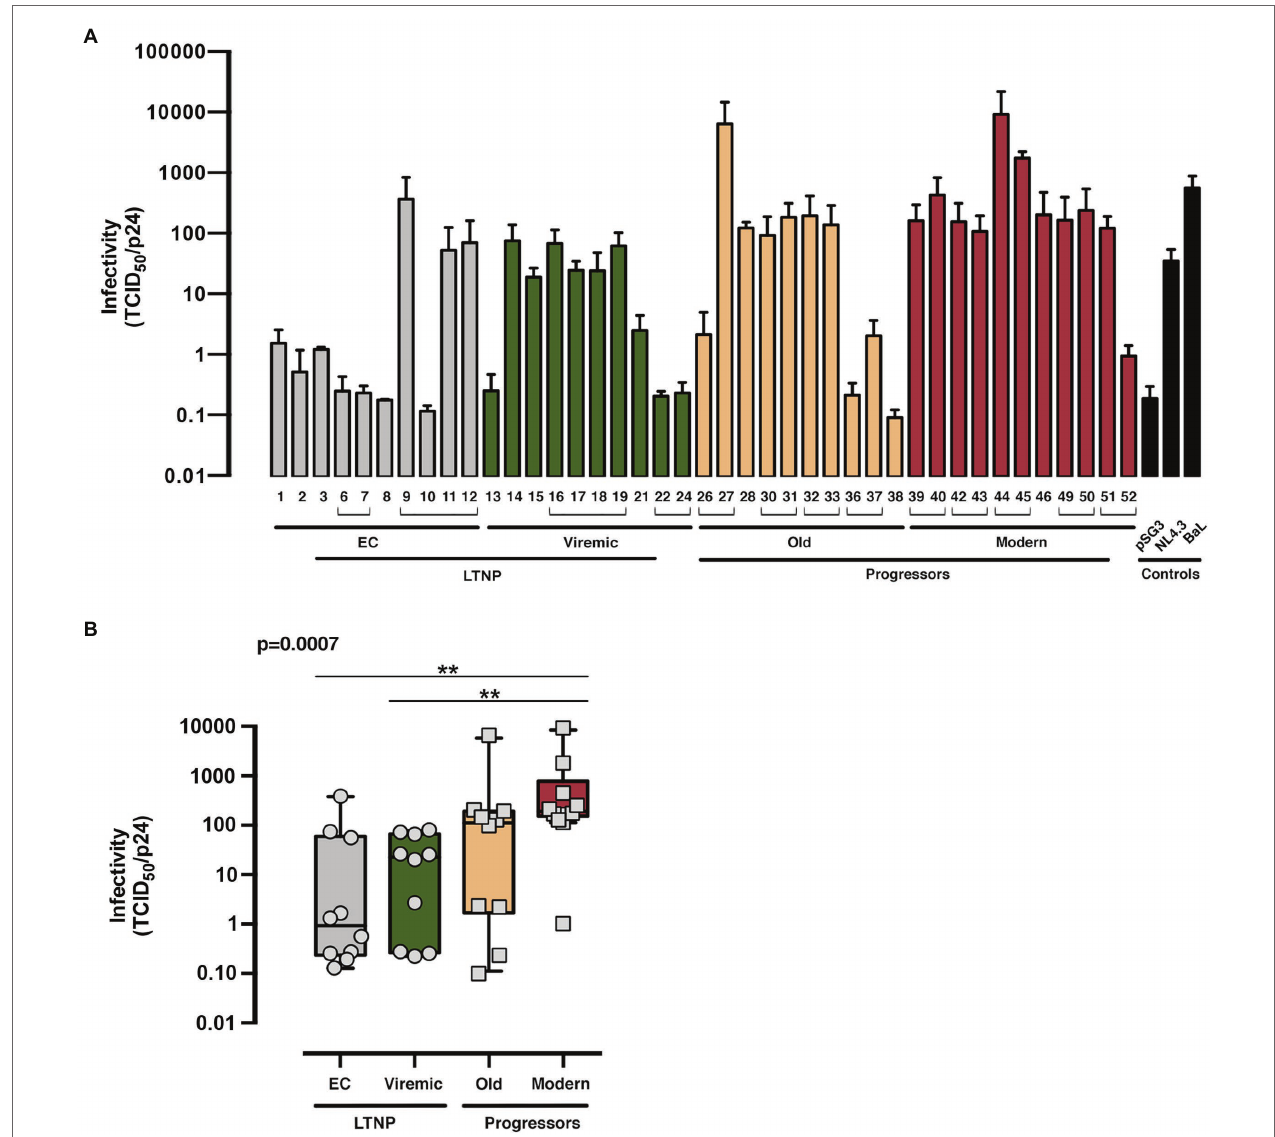
FIGURE 6 | Viral infectivity of the viral Envs. Analysis of the infecivity (TCID 50 value normalized by viral p24 input) of the different of HIV-1 Env proteins obtained from LTNP-EC ( gray bars ), vLTNP ( green bars ), Old ( orange bars ), and Moderns ( red bars ) patients or reference HIV-1 viral strains (pSG3, NL4.3, and BaL, black bars ). Analysis of Env infectivity for each patient (A) and in each group where values of p compare medians between groups using a nonparametric Kruskal–Wallis, Dunn’s Multiple Comparisons Test (B) are shown. Envs isolated from the same patient are associated with brackets in (A) ; p value for comparison between all groups is shown, top left . When indicated, comparative p value is ** p <0.05. Values are mean ± SEM of three independent experiments ( n =